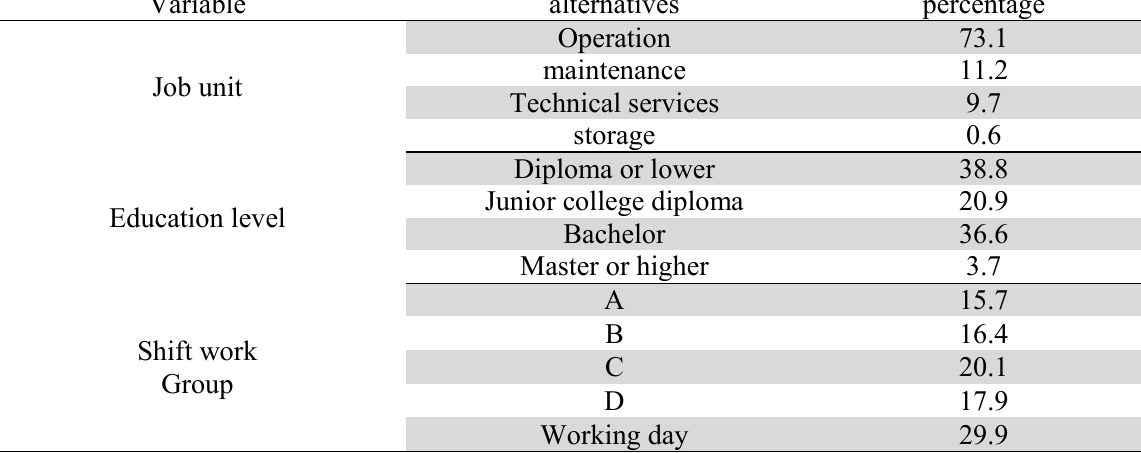
Frequencies of individual according to job unit, Education level and shift work